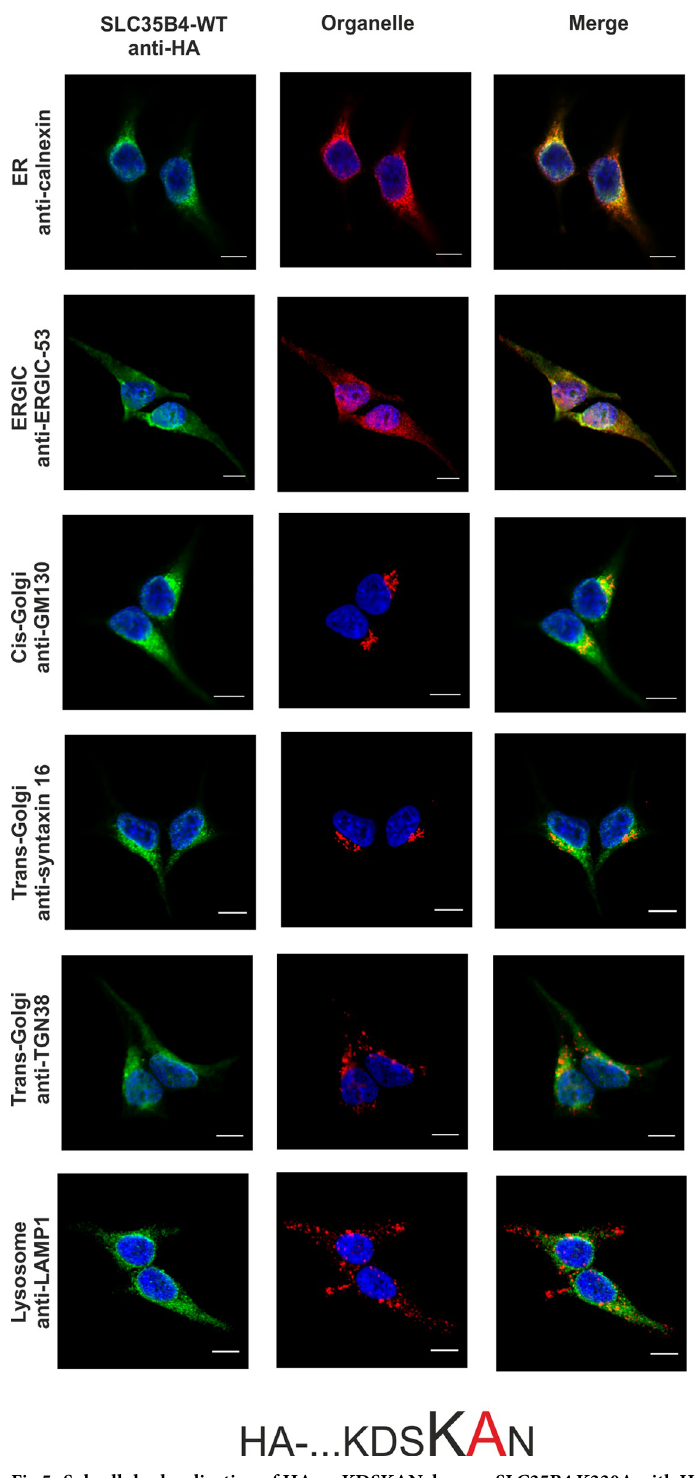
Fig 5. Subcellular localization of HA- ... KDSKAN, human SLC35B4 K330A with HA-epitope at the N-terminus in the wild-type HepG2 cells. Stably transfected wild-type (SLC35B4-WT) cells, overexpressing SLC35B4 variants, were subjected to indirect immunofluorescent staining with anti-HA (green) and anti-organelle markers (Table 3) (red) antibodies. Cell nuclei were counterstained with DAPI. Scale bar 10 μ m.